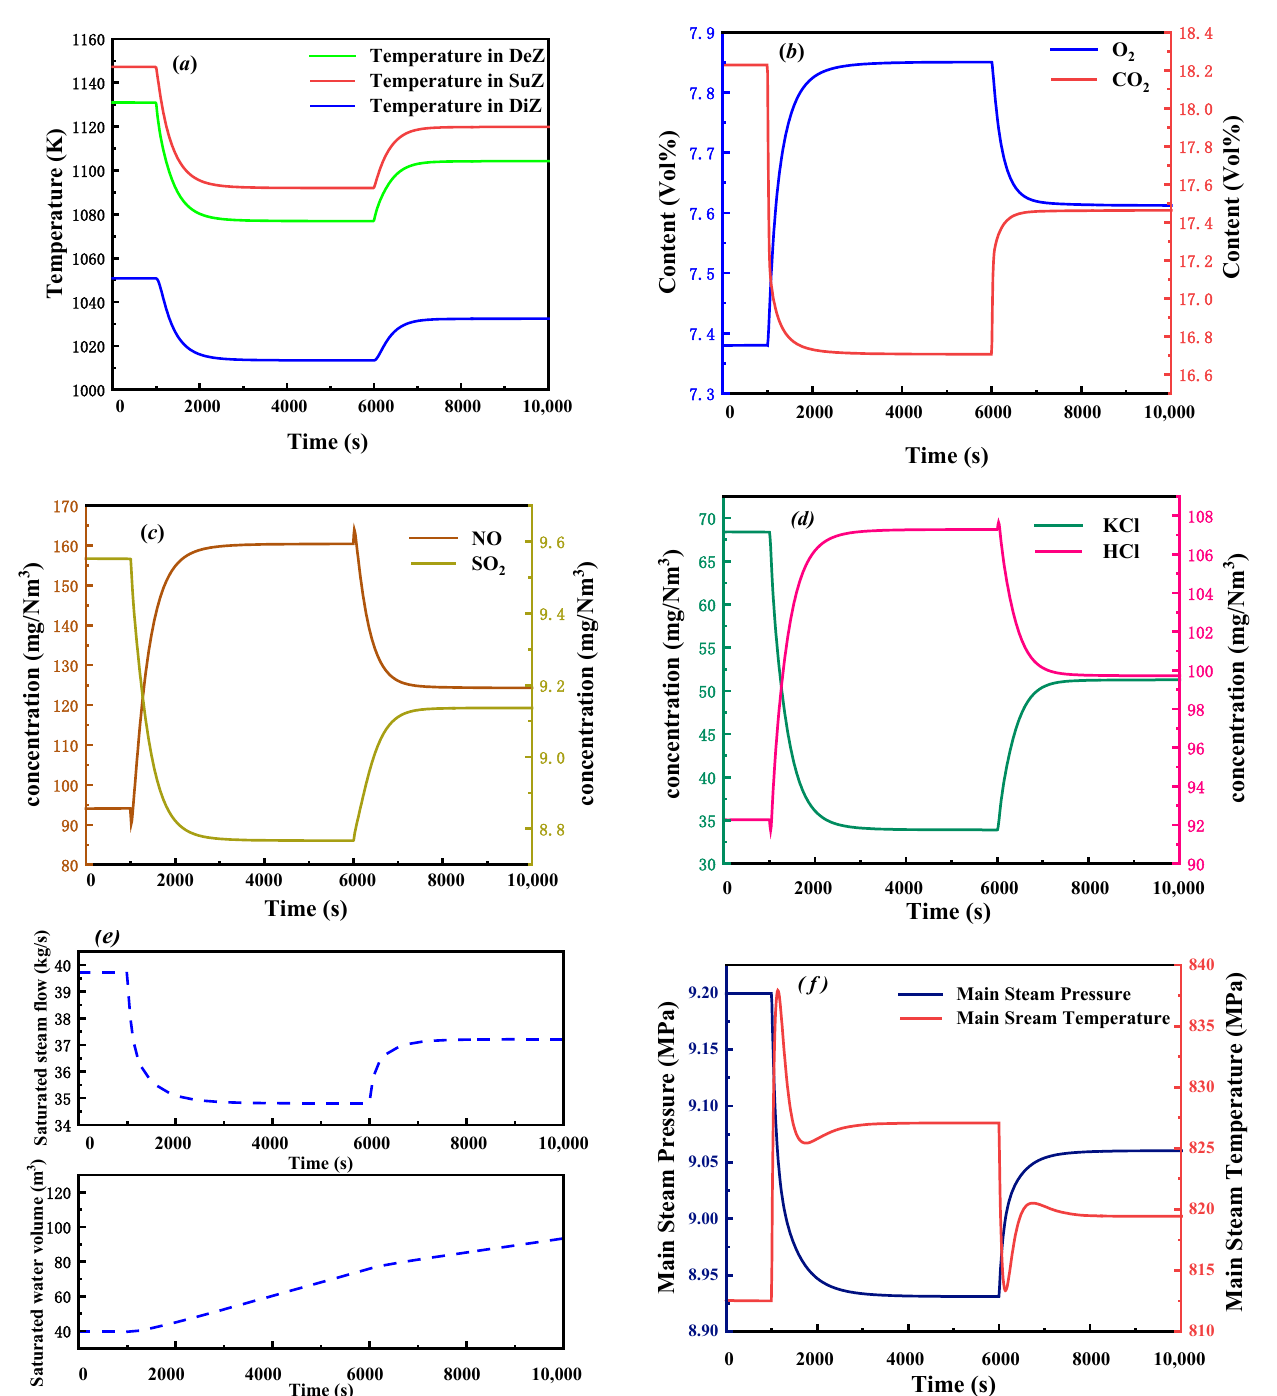
Figure 5. ( a ) Furnace temperature response ( b ) O 2 , CO 2 response ( c ) NO, SO 2 response ( d ) KCl, HCl response ( e ) Saturated steam flow and saturated water volume response ( f ) Main steam pressure and temperature response.